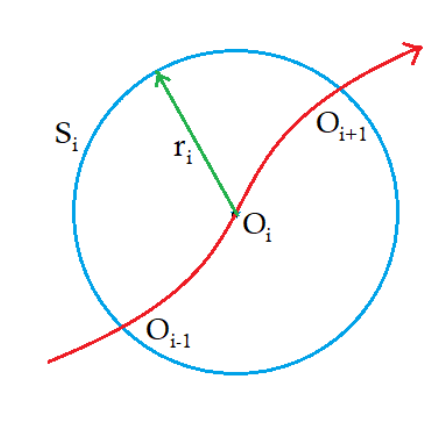
Figure 1. Environment map.